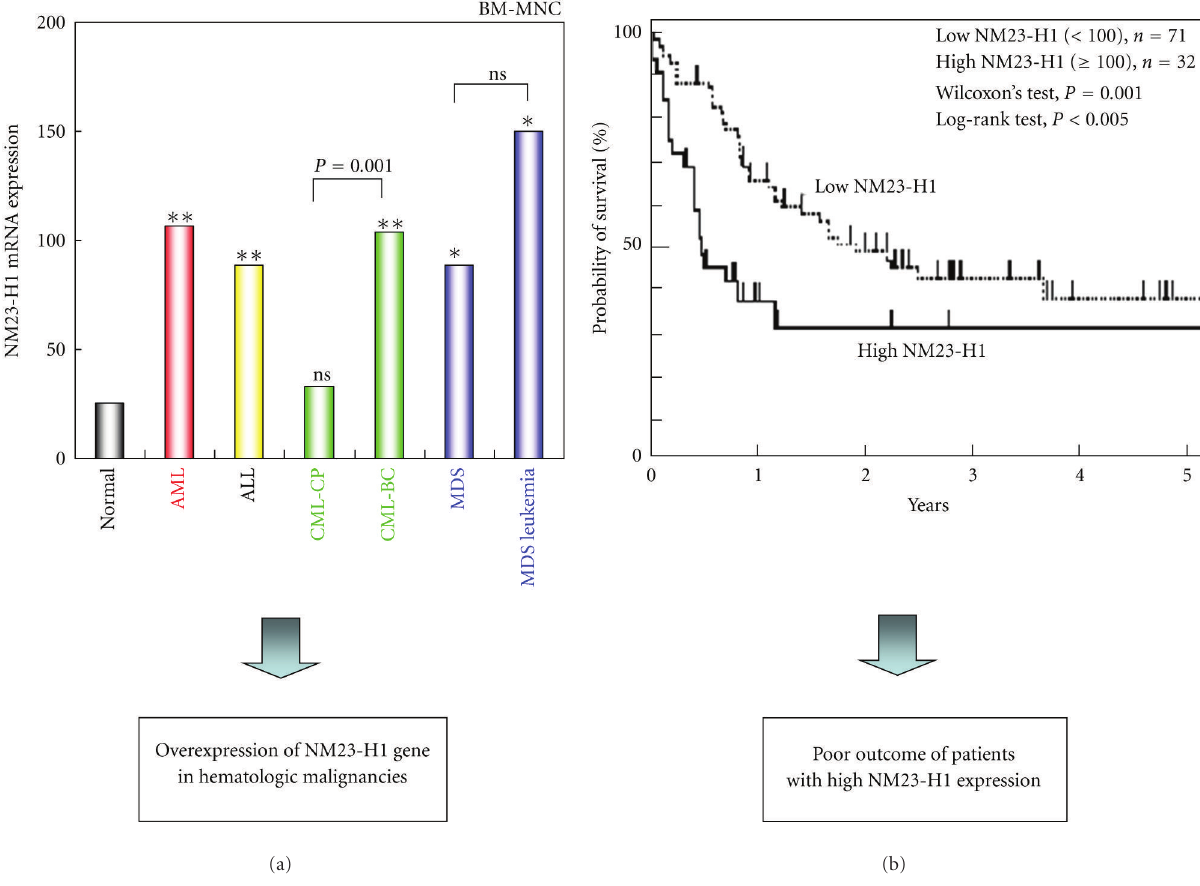
Figure 1: Clinical significance of NM23-H1 expression in hematologic malignancies. (a) Overexpression of NM23-H1 gene in hematologic malignancies [10, 20, 31]. Quantitative RT-PCR analysis on NM23-H1 mRNA in human bone marrow mononuclear cells (BM-MNC) in normal ( n = 5), AML ( n = 110), acute lymphoblastic leukemia (ALL, n = 9), and chronic myelogenous leukemia in the chronic phase (CML-CP, n = 9), CML in blast crisis (CML-BC, n = 7), myelodysplastic syndrome (MDS, n = 9), MDS overt leukemia ( n = 5). The mRNA levels were normalized for gapdh mRNA. The positive control (the index = 100) is represented by RNA extracted from the human leukemia cell line (HEL). Mann-Whitney’s U test (versus normal), ∗ P < 0 . 05, ∗∗ P < 0 . 001. (b) Overall survival curves of patients with AML, according to NM23-H1 expression level [31]. High NM23-H1 ( > 100 index) patients ( n = 32, solid line) had a worse prognosis than low NM23-H1 ( ≤ 100) patients ( n = 71, broken